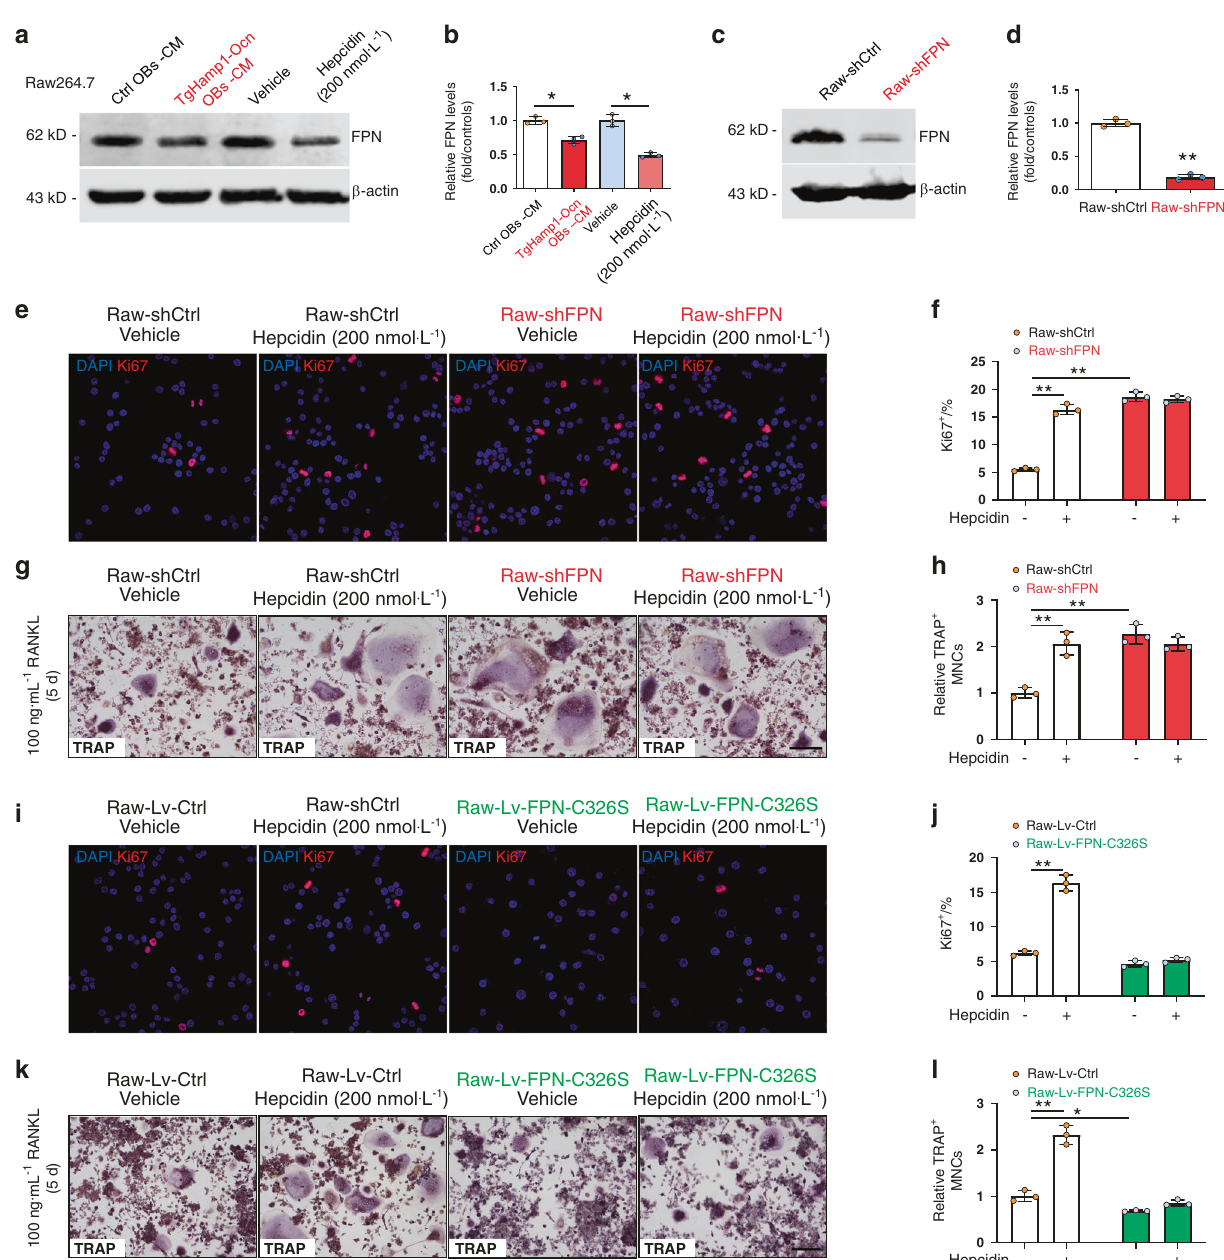
Fig. 5 FPN regulates the proliferation and differentiation of RAW264.7 cells. a , b FPN protein levels in RAW264.7 cells after 4 h of treatment with Ctrl OB-CM, TgHamp1-Ocn OB-CM, vehicle or 200 nmol·L − 1 hepcidin peptide. FPN levels were analyzed by western blotting. Representative blots are shown in ( a ). Quantitative data (the mean ± SD of three separate experiments) are presented in ( b ). * P < 0.05. c , d Western blot analysis of FPN expression in Ctrl and FPN-KD RAW264.7 cells. Quantitative data (the mean ± SD of three separate experiments) are presented in ( d ). ** P < 0.01. e , f Immunostaining analyses of Ki67 in RAW264.7 cells. Ctrl and FPN-KD RAW264.7 cells were treated with vehicle or hepcidin (200 nmol·L − 1 ) for 1 d. Quantitative data are shown in f . The data are presented as the mean ± SD of three separate experiments. ** P < 0.01. g , h TRAP staining of RAW264.7 cells. Ctrl and FPN-KD RAW264.7 cells were treated with vehicle or hepcidin (200 nmol·L − 1 ) and 100 ng·mL − 1 RANKL for 5 d. Bar, 200 μ m. Quanti fi cation of TRAP + MNCs is shown in h . The data are presented as the mean ± SD of three separate experiments; ** P < 0.01. i , j Immunostaining analyses of Ki67 in RAW264.7 cells. Lv-Ctrl and Lv-FPN-C326S-transfected cells were treated with vehicle or hepcidin (200 nmol·L − 1 ) for 1 d. Quantitative data are shown in j . The data are presented as the mean ± SD of three separate experiments. ** P < 0.01. k , l TRAP staining of RAW264.7 cells. Lv-Ctrl and Lv-FPN-C326S-transfected cells were treated with vehicle or hepcidin (200 nmol·L − 1 ) and 100 ng·mL − 1 RANKL for 5 d. Bar, 200 μ m. The number of TRAP + MNCs is shown in l . The data are presented as the mean ± SD of three separate experiments. * P < 0.05; ** P <